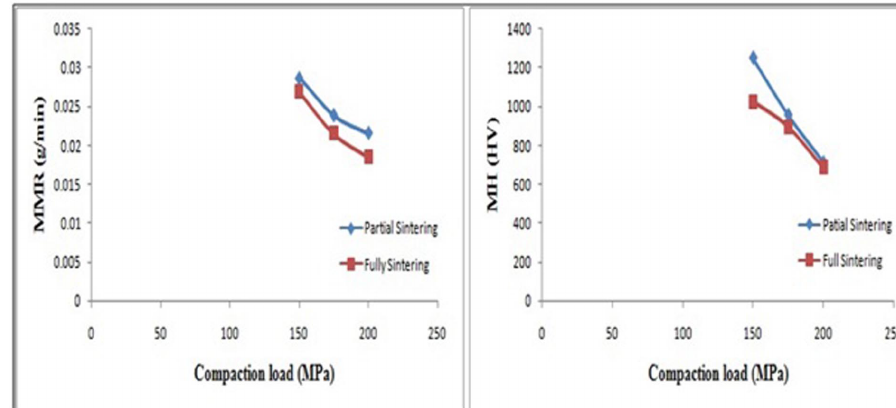
Figure 3: Effect of compaction load on MMR and MH